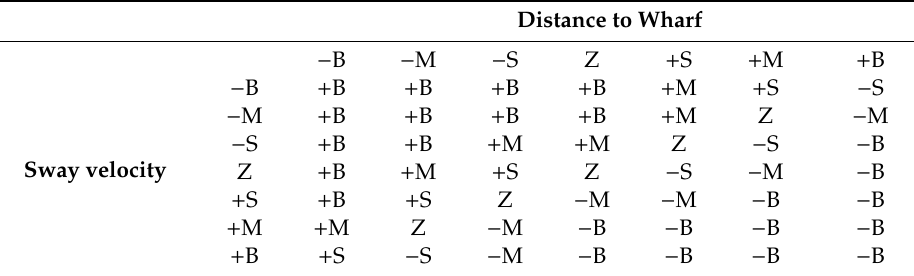
Table 7. The rule base for the third